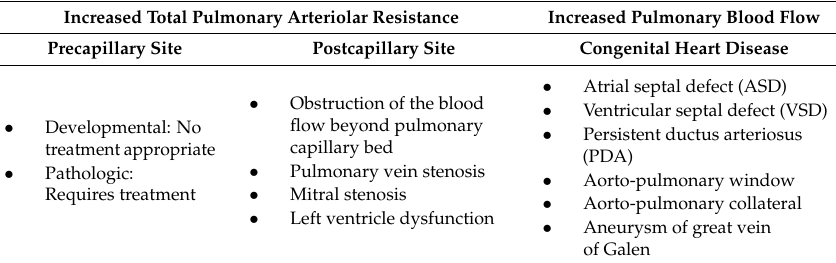
Table 1. Aspects of pulmonary hypertension